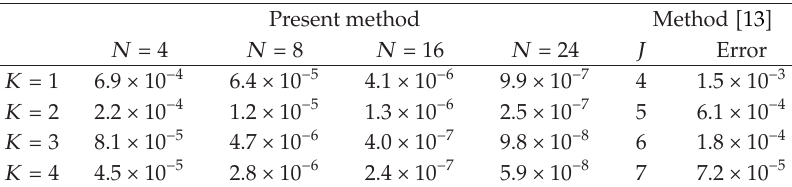
Table 4: Comparison of maximum absolute errors for Example